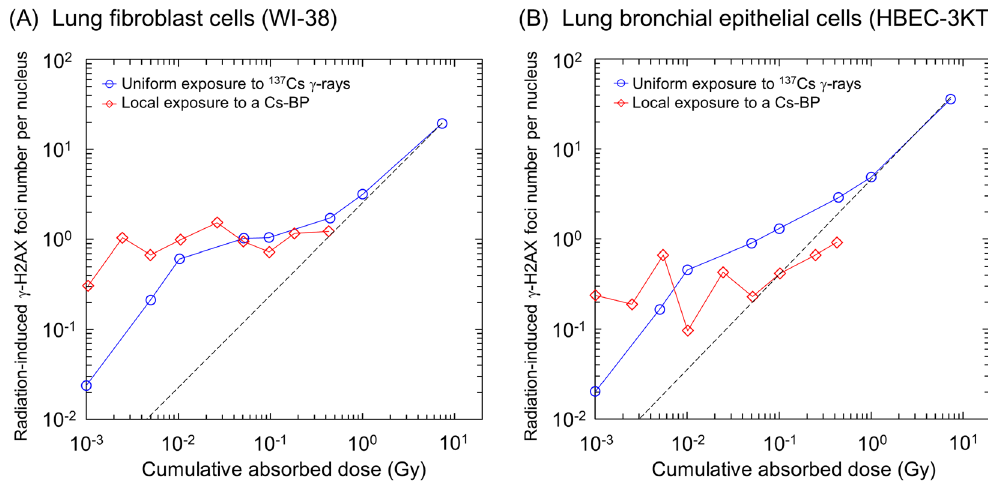
Figure 4. Comparison of DSB induction between localized exposure to Cs-bearing particle (Cs-BP) and uniform exposure. ( A ) Lung fibroblast cells (WI-38), ( B ) Lung bronchial epithelial cells (HBEC-3KT). The mean number of γ -H2AX foci detected after 24 h exposure to the Cs-BP was linked to absorbed dose calculated by PHITS. The solid lines are for eye guide. The dotted line represents the interpolation between high dose data with 7.29 Gy and the origin, corresponding to the prediction based on DNA-targeted effects. The mean number of foci per nucleus by the Cs-BP is intersecting with that by uniform exposure to 137 Cs γ -rays in a dose range of about 50 mGy for WI-38 cells, about 5–10 mGy for HBEC-3KT cells.